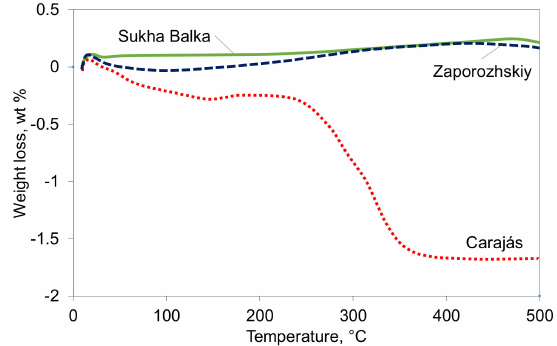
Figure 3. Characterization of the studied iron ores with TG analysis.